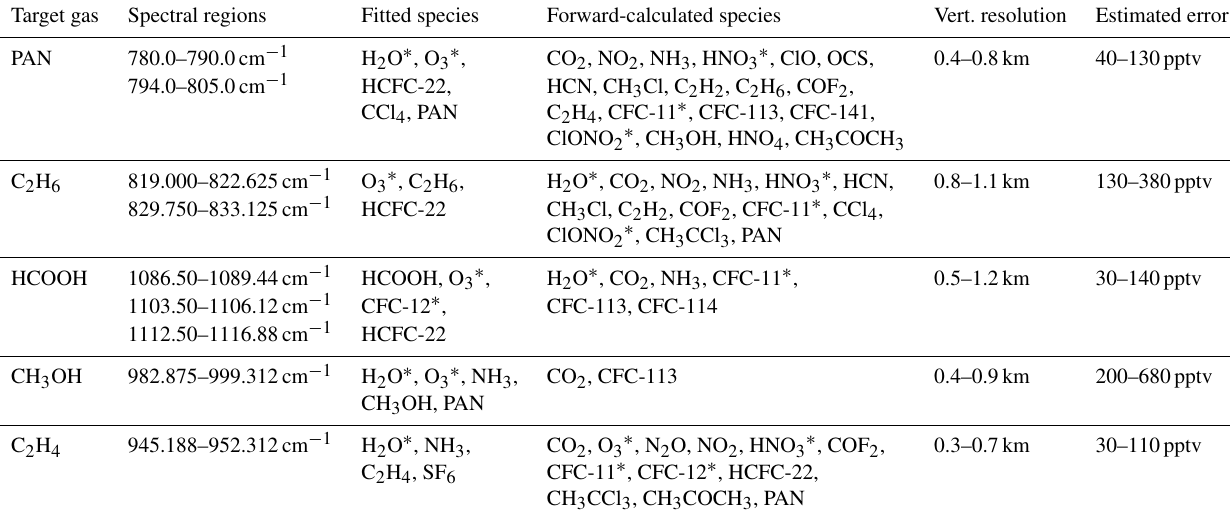
Table 2. Retrieval properties for PAN, C 2 H 6 , HCOOH, CH 3 OH, and C 2 H 4 : Spectral regions used, and handling of interfering species. 10 and 90 percentile ranges are given for vertical resolution and estimated errors (combination of random and systematic errors). In the Supplement, it is shown that larger absolute errors are typically connected to higher